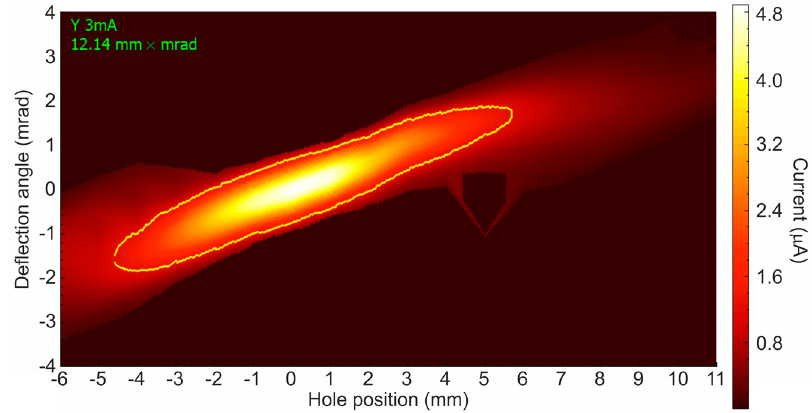
Figure 4. Phase portrait of a 2 MeV, 3 mA proton beam.